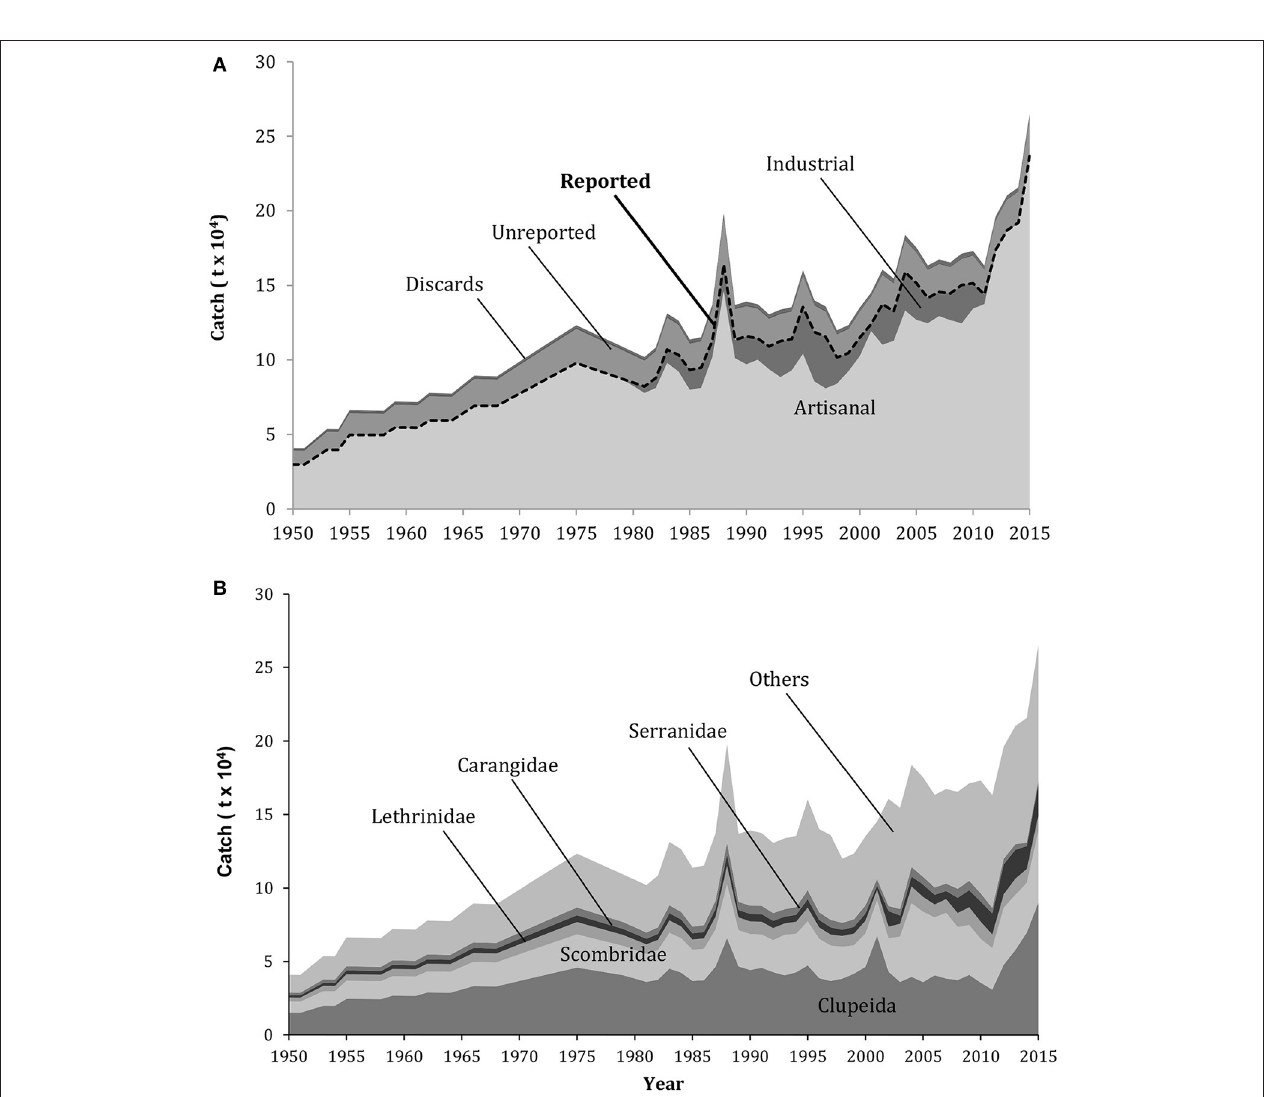
FIGURE 2 | Reconstructed catches for Oman (excluding Musandam), 1950-2015, by (A) sector, with discards shown separately, and adjusted reported landings overlaid as a dashed line graph. Subsistence and recreational catches are included, but are too small to be visible; and (B) by main taxonomic group. “Others” includes 19 additional taxonomic